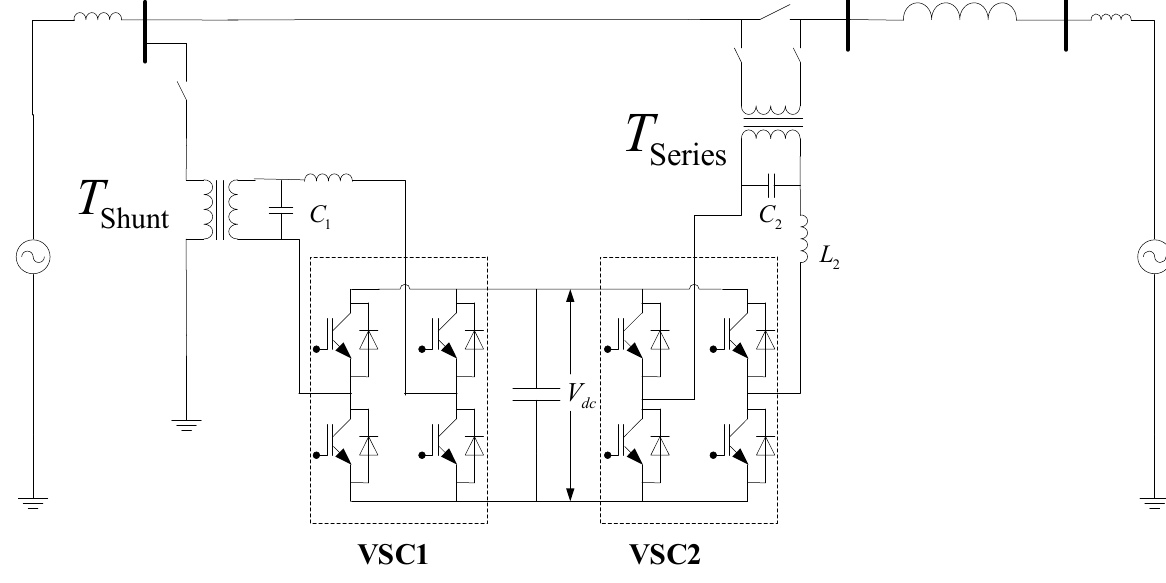
Figure 17. Schematic diagram of UPFC .